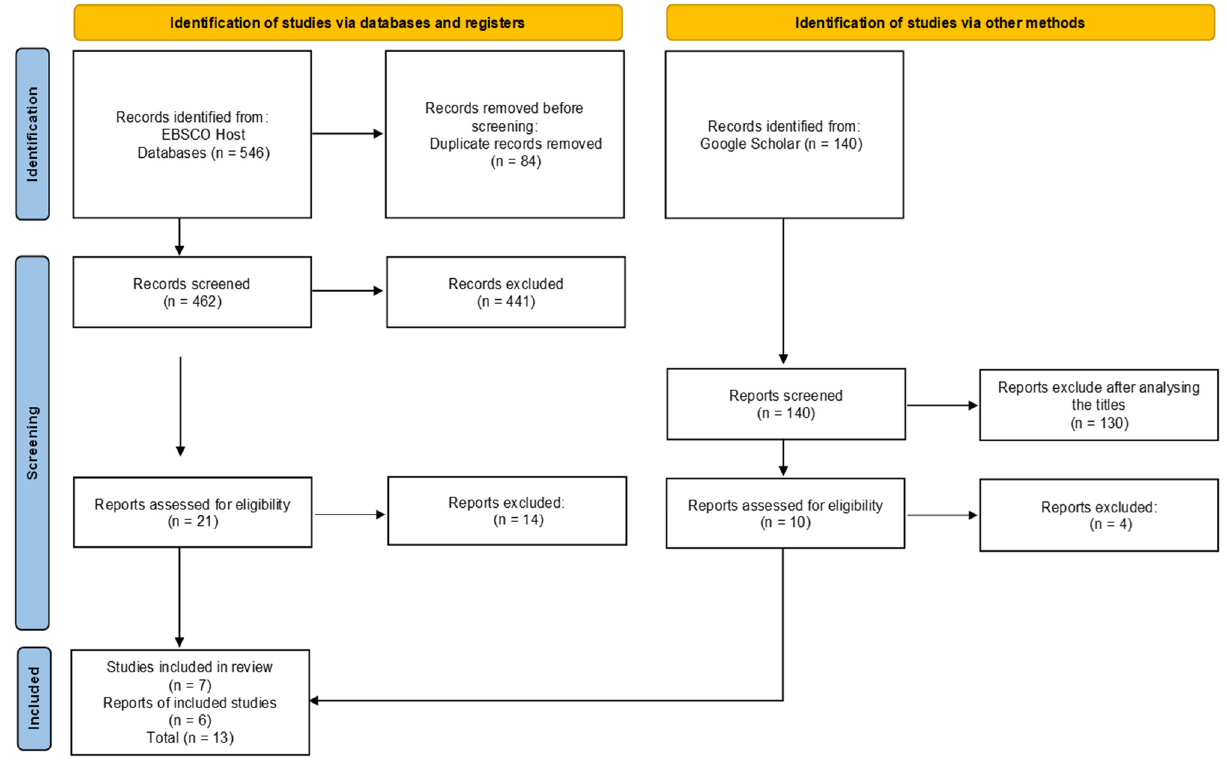
Figure 1. PRISMA–ScR flowchart. Lisbon, 2020.